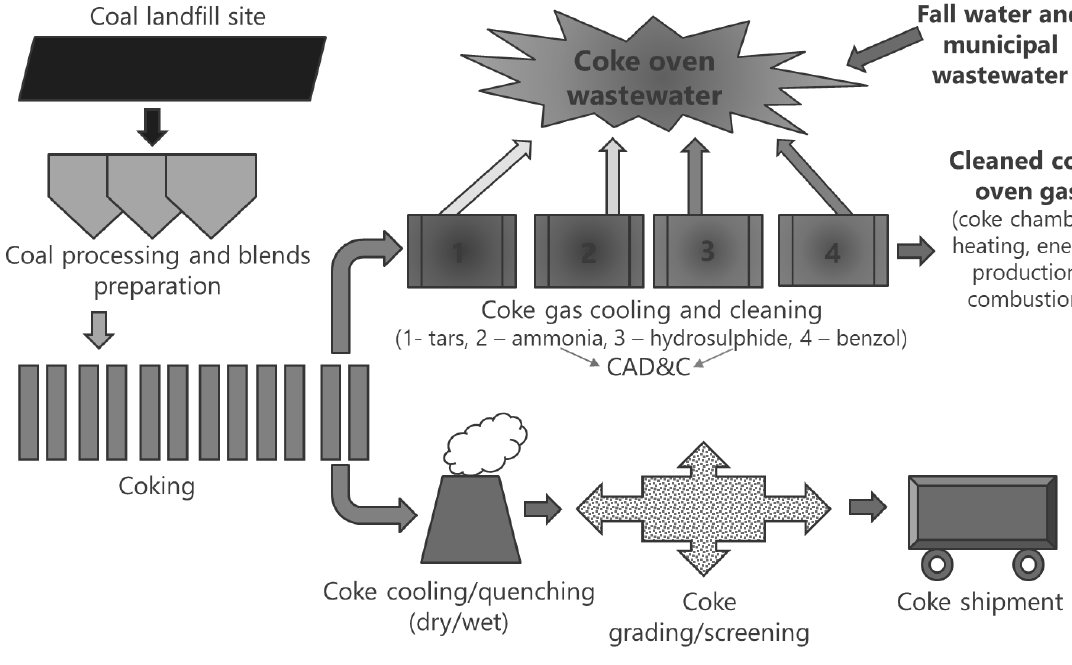
Figure 1: The scheme of coke production at a coke oven plant.